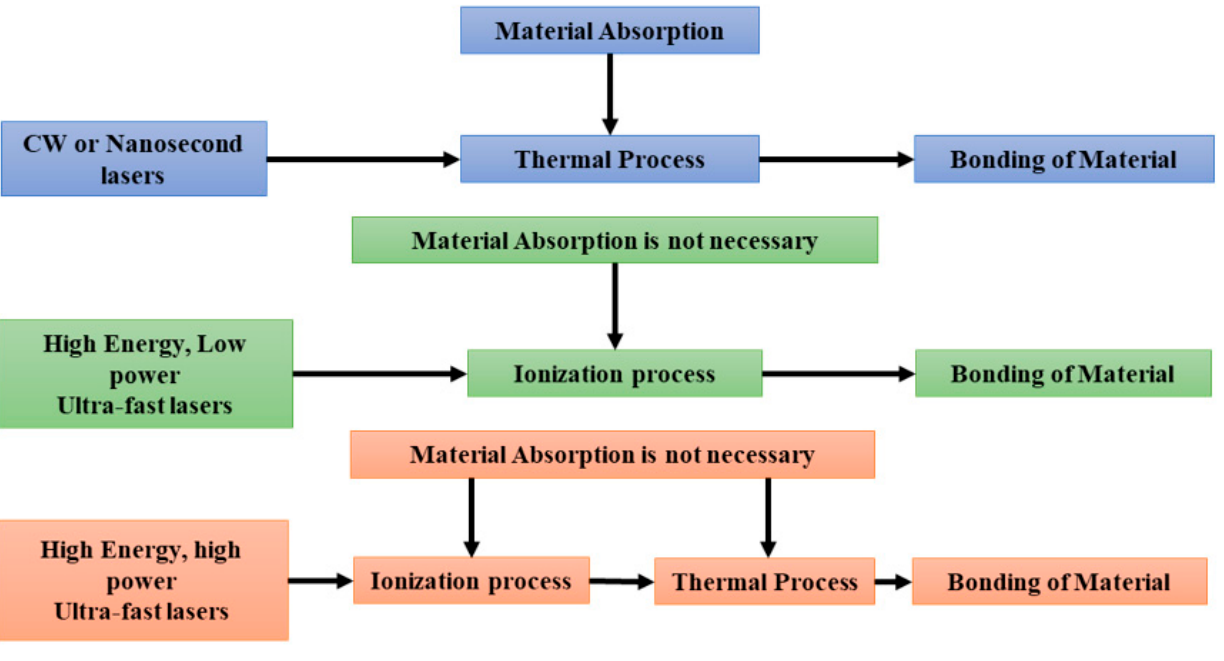
Figure 2. Comparison of CW, ns and fs laser material absorption processes [57]. Table 4. Different maximum ablation rates for various material processes